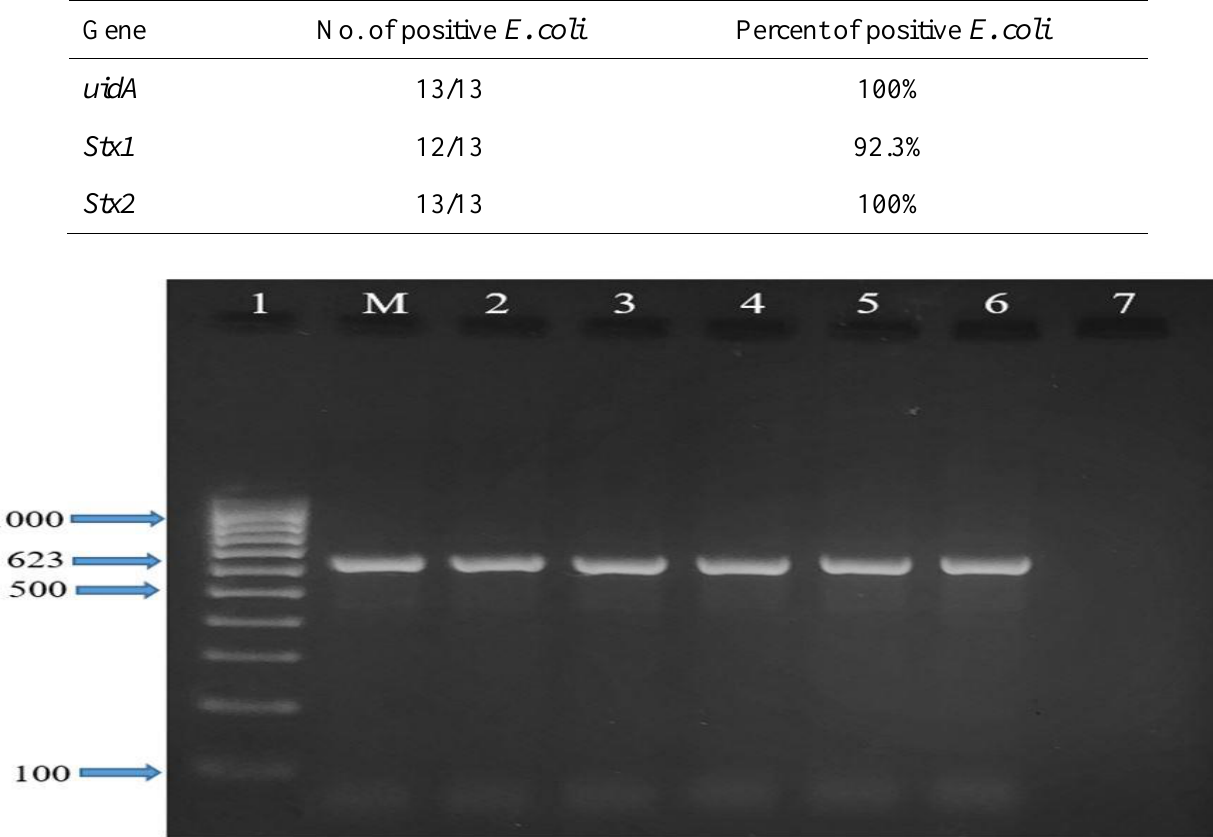
Fig.1: UidA gene product in E. coli O157:H7isolates (623